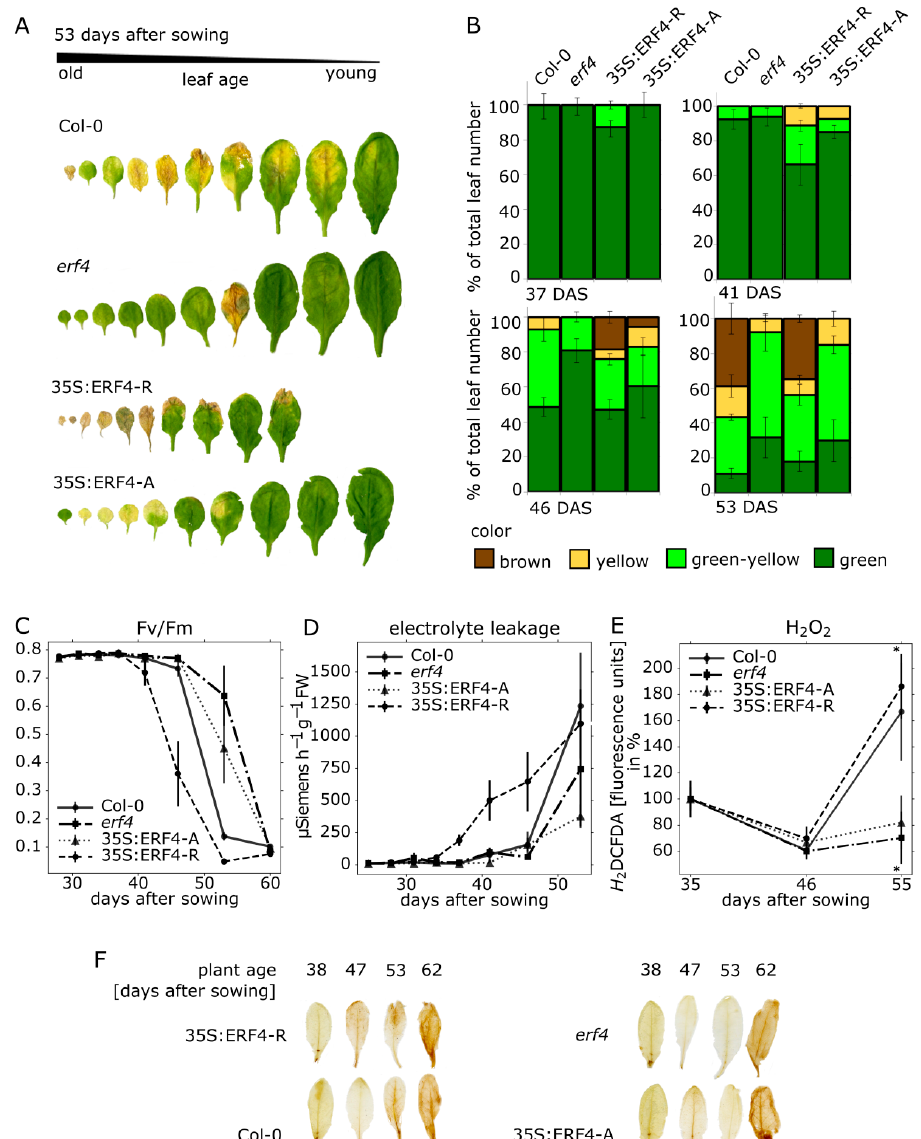
Figure 1. Senescence parameters analyzed in plant lines with altered ERF4 expression. Col-0, 35S: ERF4-R , 35S: ERF4-A and erf4 mutant plants were analyzed over development. ( A ) Representative pictures for rosette leaves No. 1–10, which were sorted according to their age 53 days after sowing (DAS). ( B ) Rosette leaves were categorized in four groups according to their color (fully green, green/yellow, fully yellow, brown/dry) and percentage of each category is depicted. ( C ) Fv/Fm values in leaf No. 5 were measured with the pulse amplitude modulation (PAM) method. ( D ) Electrolyte leakage (EL) over time was measured in single detached leaves No. 4 using a conductivity meter. Values are normalized to leaf fresh weight. ( E ) Intracellular H 2 O 2 content per leaf was measured in leaf No. 9 using the fluorescent dye H 2 DCFDA. Values are normalized to leaf weight. Data represent means of 5 (A–D) or 10 (E) biological replicates, error bars present ± SE. ( F ) H 2 O 2 content in leaf No. 9 is visualized by DAB (3,3-diaminobenzidine)-staining. One representative example is shown. Experiments were repeated three times with similar